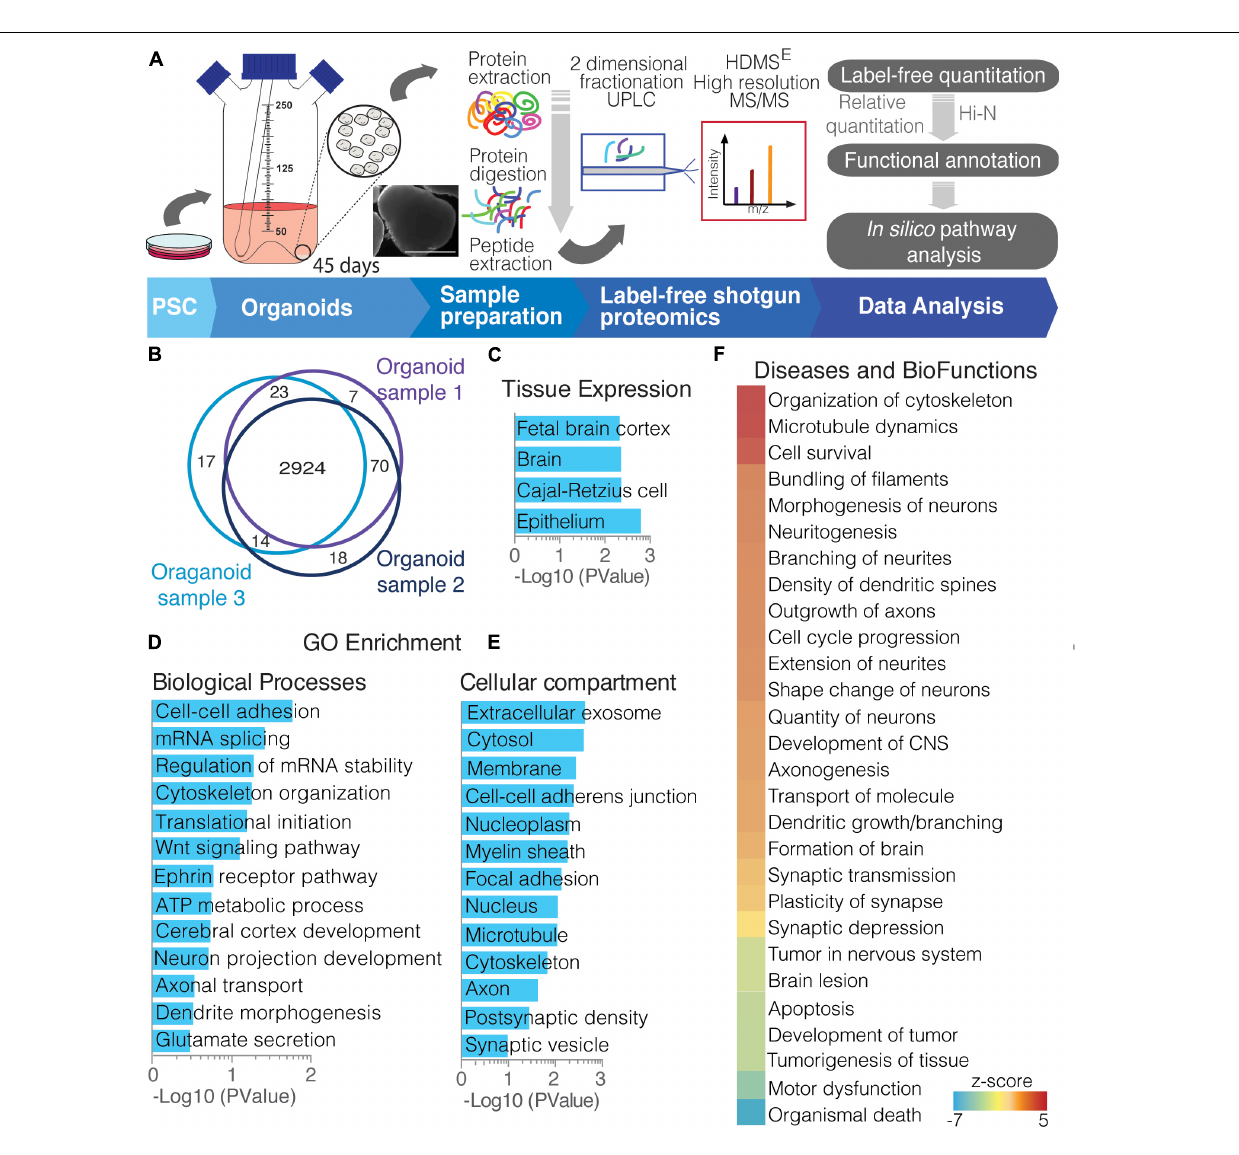
FIGURE 1 | Overview of cerebral organoid protein expression. (A) Experimental proteomics workflow, from collecting cerebral organoids and processing to proteomic studies. After sample preparation (extraction and digestion), peptides underwent a 2D-UPLC fractionation and on-line detection using HDMS E high resolution MS/MS acquisition. The acquired peptides were deconvoluted, identified, and quantified using the software Progenesis, whereupon proteins were identified and quantified. This was followed by functional annotation of protein groups and other in silico analyses. (B) Venn diagram showing commonly found proteins among cerebral organoids replicates (PSC-derived samples). Functional annotation analyses of proteins commonly found in replicates are clustered by (C) tissue expression; gene ontology using (D) biological function and (E) cellular compartment distribution; and (F) diseases and biofunctions